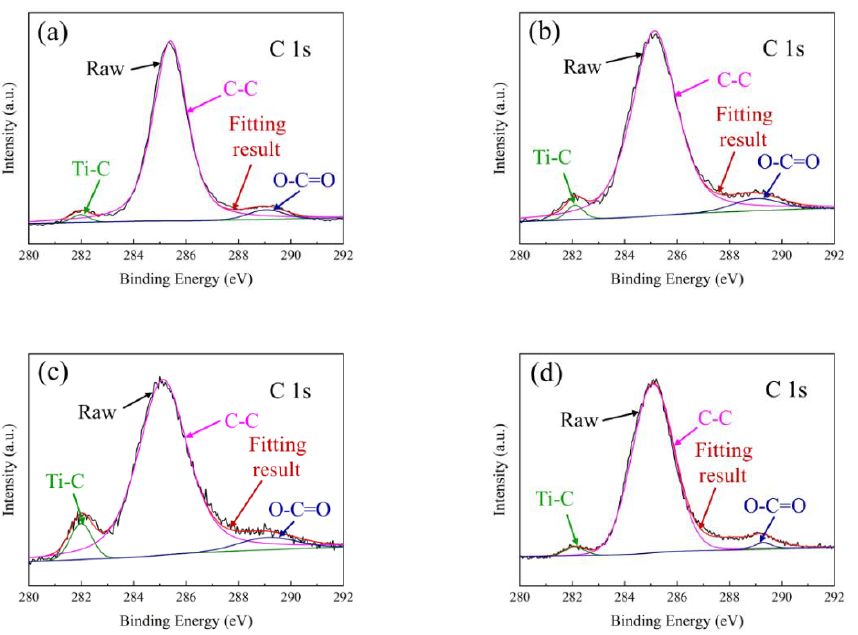
Figure 9. C1s XPS spectrum of DLC film deposited on titanium at ( a ) CH 4 /H 2 = 1:1, 6 h; ( b ) CH 4 /H 2 = 1:1, 12 h; ( c ) CH 4 /H 2 = 1:0, 6 h; ( d ) CH 4 /H 2 = 1:0, 12 h.